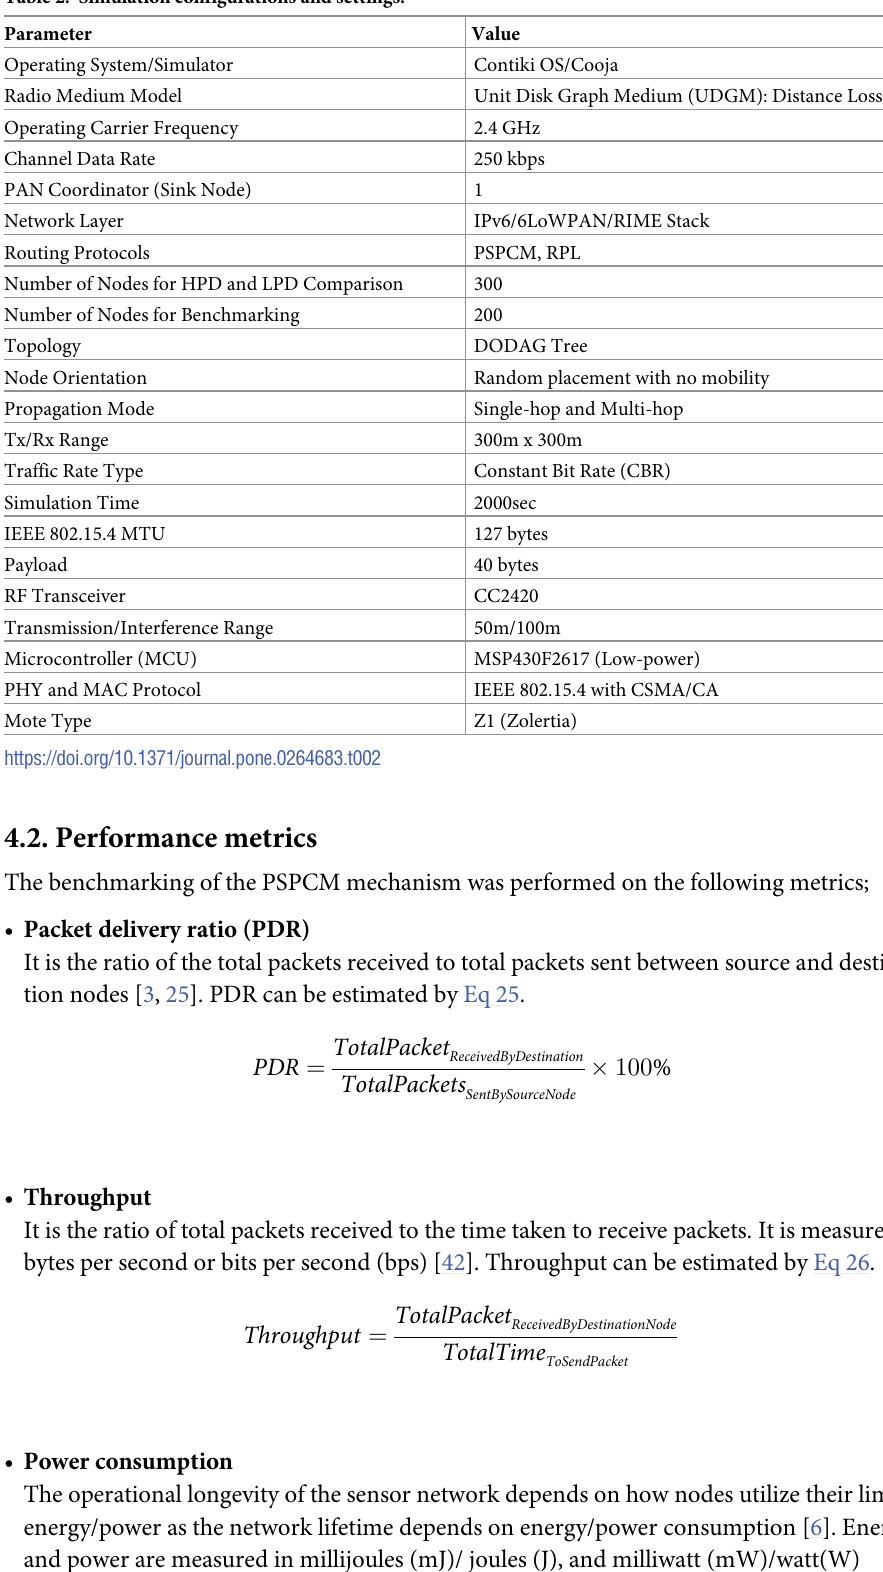
Table 2. Simulation configurations and